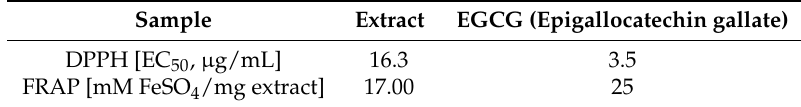
Table 2. Antioxidant activities of the methanol extract of A. harveyi leaves.